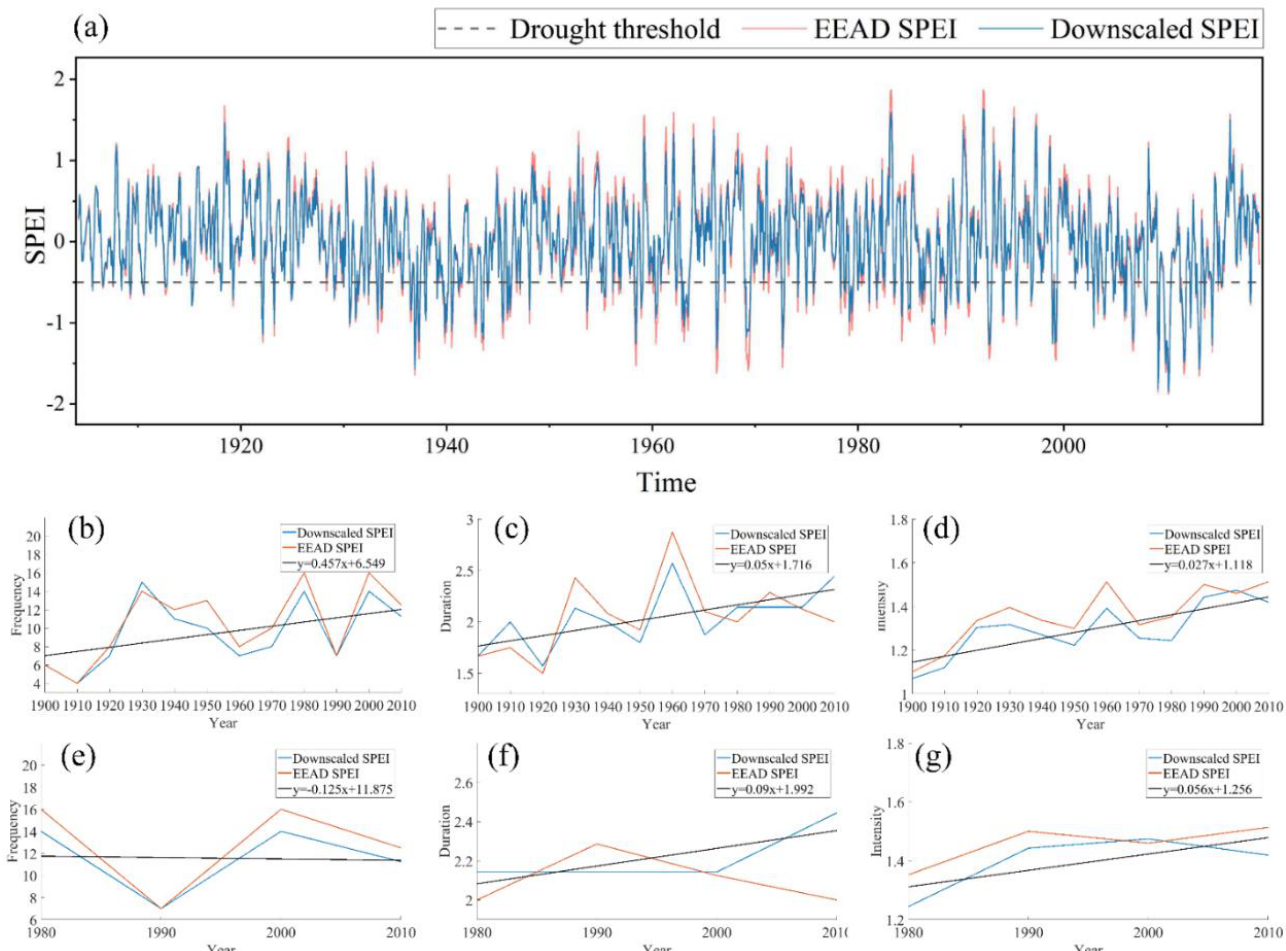
Figure 8. The temporal evolution of SPEI and interdecadal changes of the frequency, duration and intensity of drought events from 1901 to 2018 and 1980 to 2018: ( a ) the time series of SPEI; ( b ) the frequency of drought events from 1901 to 2018; ( c ) the duration of drought events from 1901 to 2018; ( d ) the intensity of drought events from 1980 to 2018; ( e ) the frequency of drought events; ( f ) the duration of drought events from 1980 to 2018; ( g ) the intensity of drought events from 1980 to 2018. Black line in b-g is the trend of downscaled SPEI.